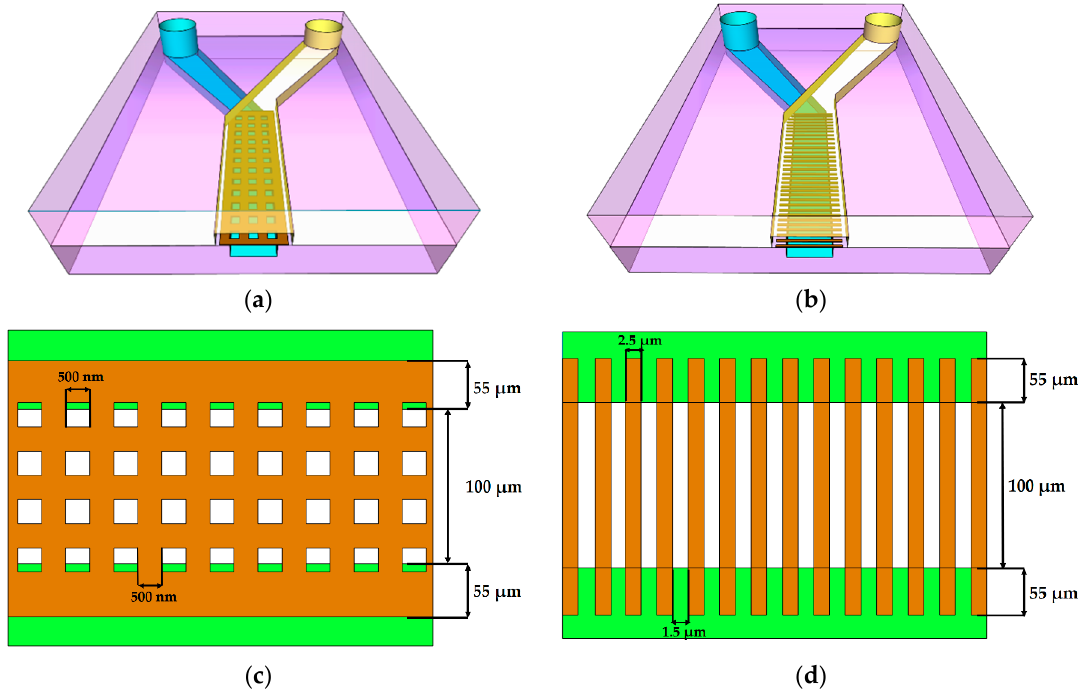
Figure 3. First ( a , c ) and second ( b , d ) proposed microfabricated structures, where ( a ) and ( b ) are the 3D model of the entire structure including two microfluidic channels with a square grid membrane and a wire membrane; ( c ) and ( d ) are 2D top views of the membranes with the annotated dimensions of the periodic structures.